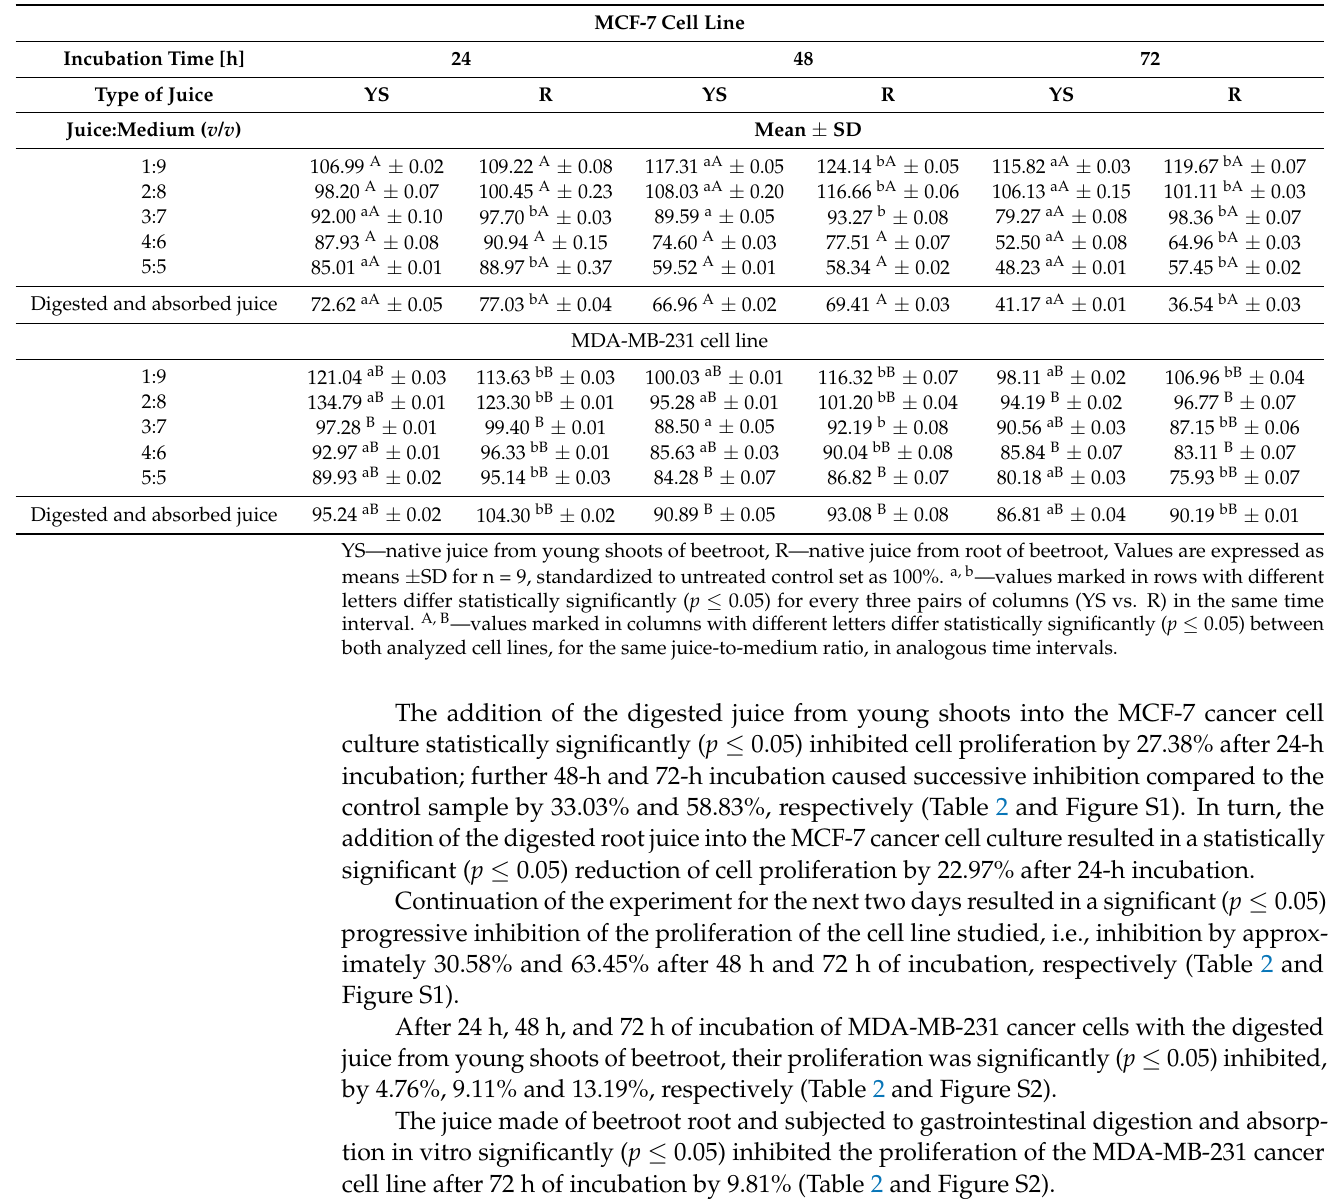
Table 2. Comparison of changes in the proliferation of MCF-7 and MDA-MB-231 breast cancer cell lines (%